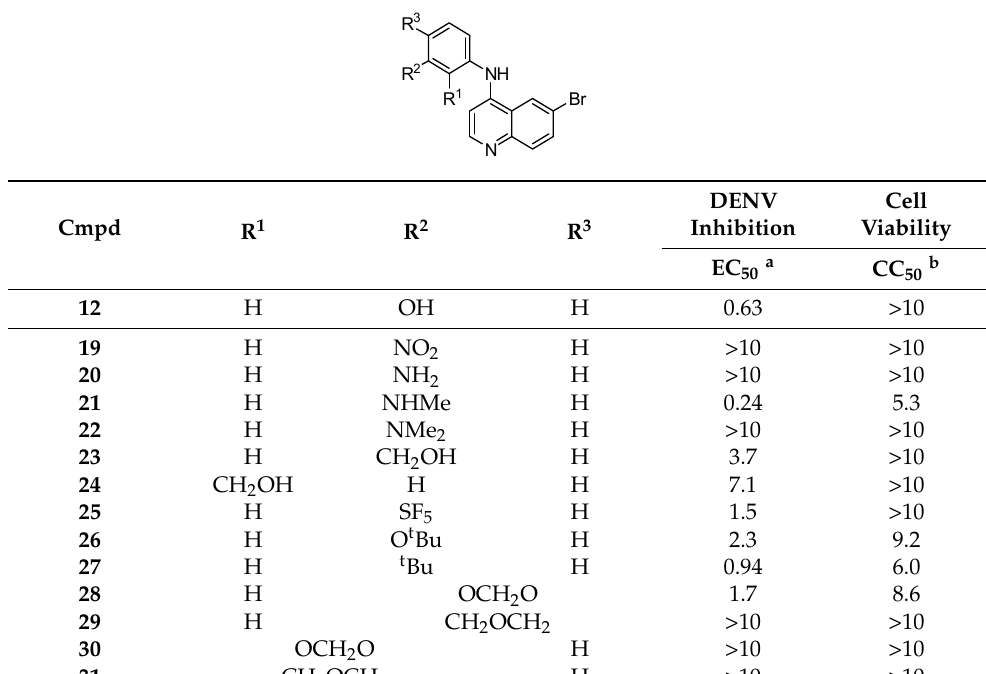
Table 3. Screening results of anti-DENV activity of analogues of 12 .